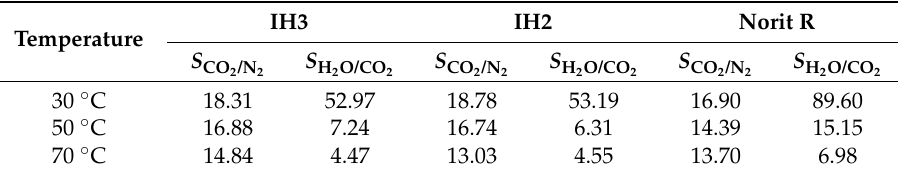
Table 3. Equilibrium selectivity factors calculated for IH3, IH2 and Norit